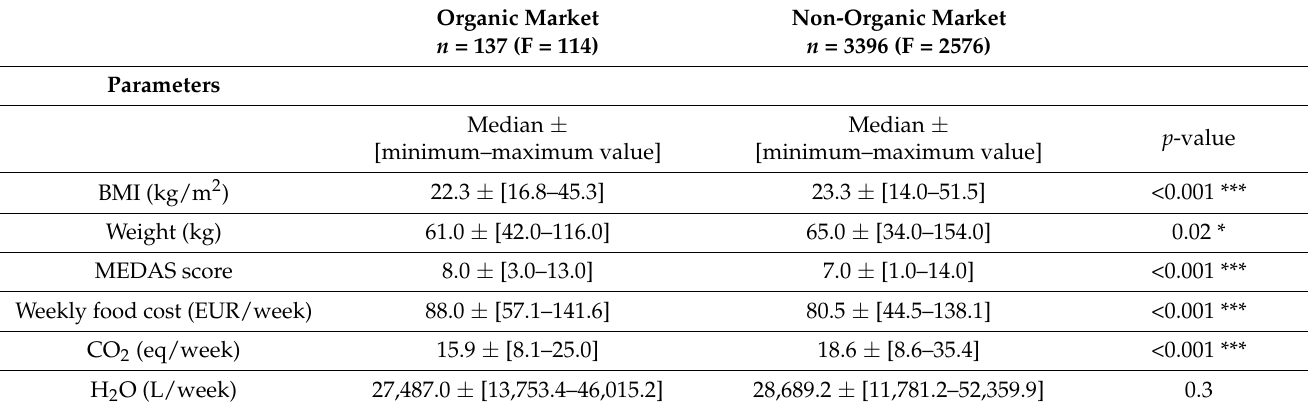
Table 9. Comparisons between organic and non-organic